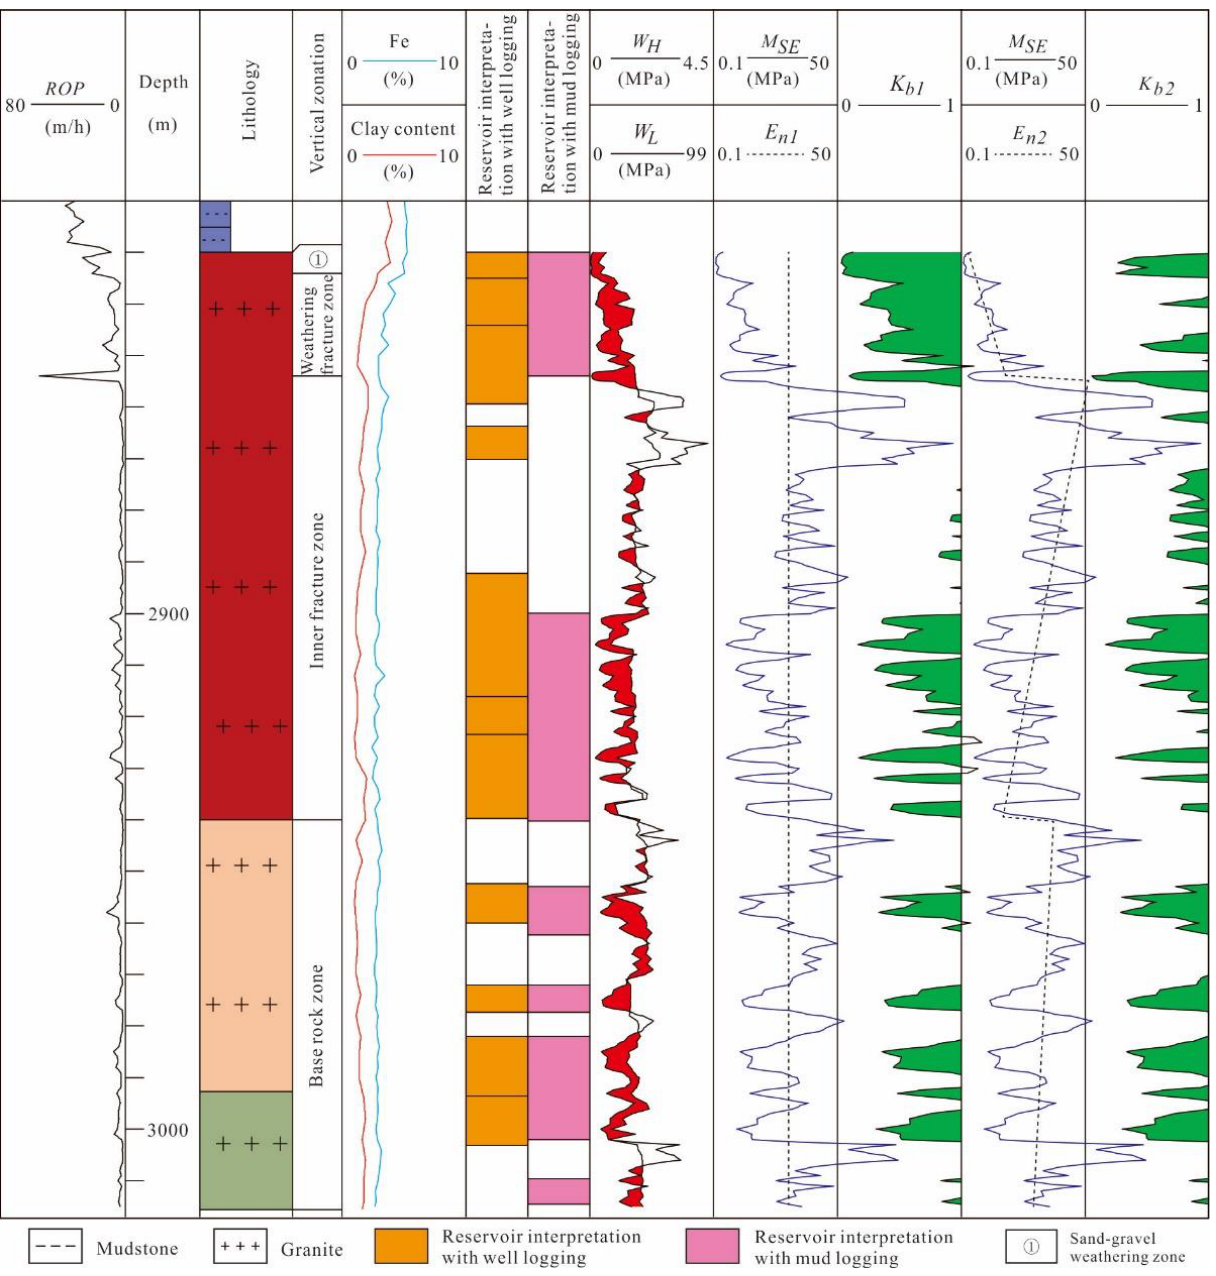
Figure 4. Mud-logging characteristics of zonation and reservoir interpretation with mud-logging data of intrusive rock buried-hill of Well Y831. E n1 is the basic value calculated with the M SE geometrical mean of the base rock zone. K b 1 is equal to M SE divided by E n1 in correspondence with the depth. E n2 is the basic value calculated by piecewise fitting based on the linear correlation of M SE in correspondence with the depth. K b 2 is equal to M SE divided by E n2 in correspondence with the depth.